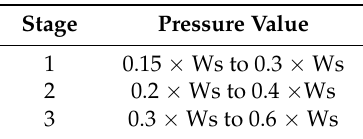
Table 2. Cyclic pressure test pressures [31].